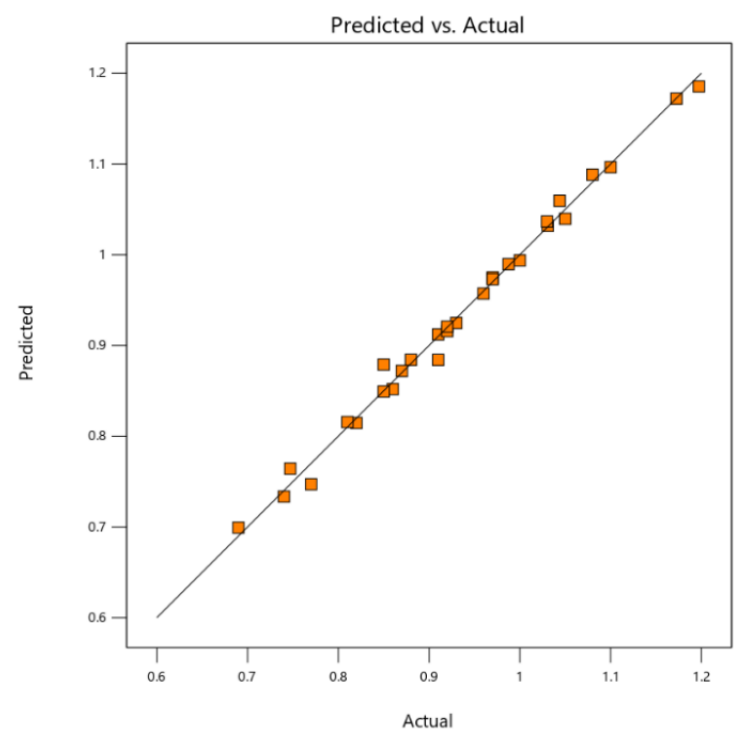
Figure 18. Comparison between model prediction and actual values. Table 4. Variance analysis of CP regression